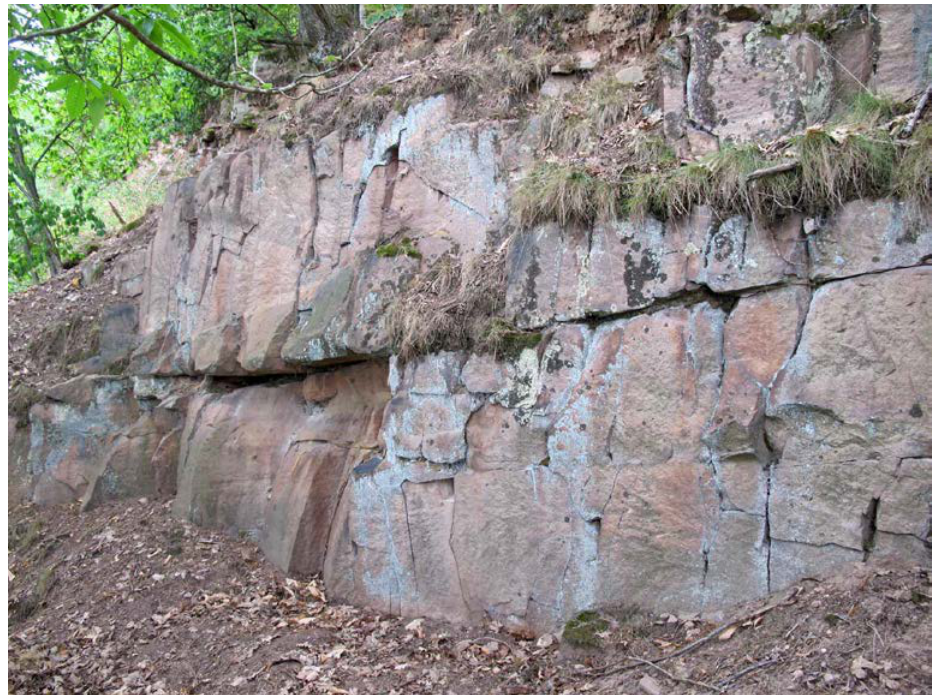
Figure 2. Planar fractured sandstone quarry face indicative of angular block or slab extraction (photo: Fl. Jodry, Inrap).